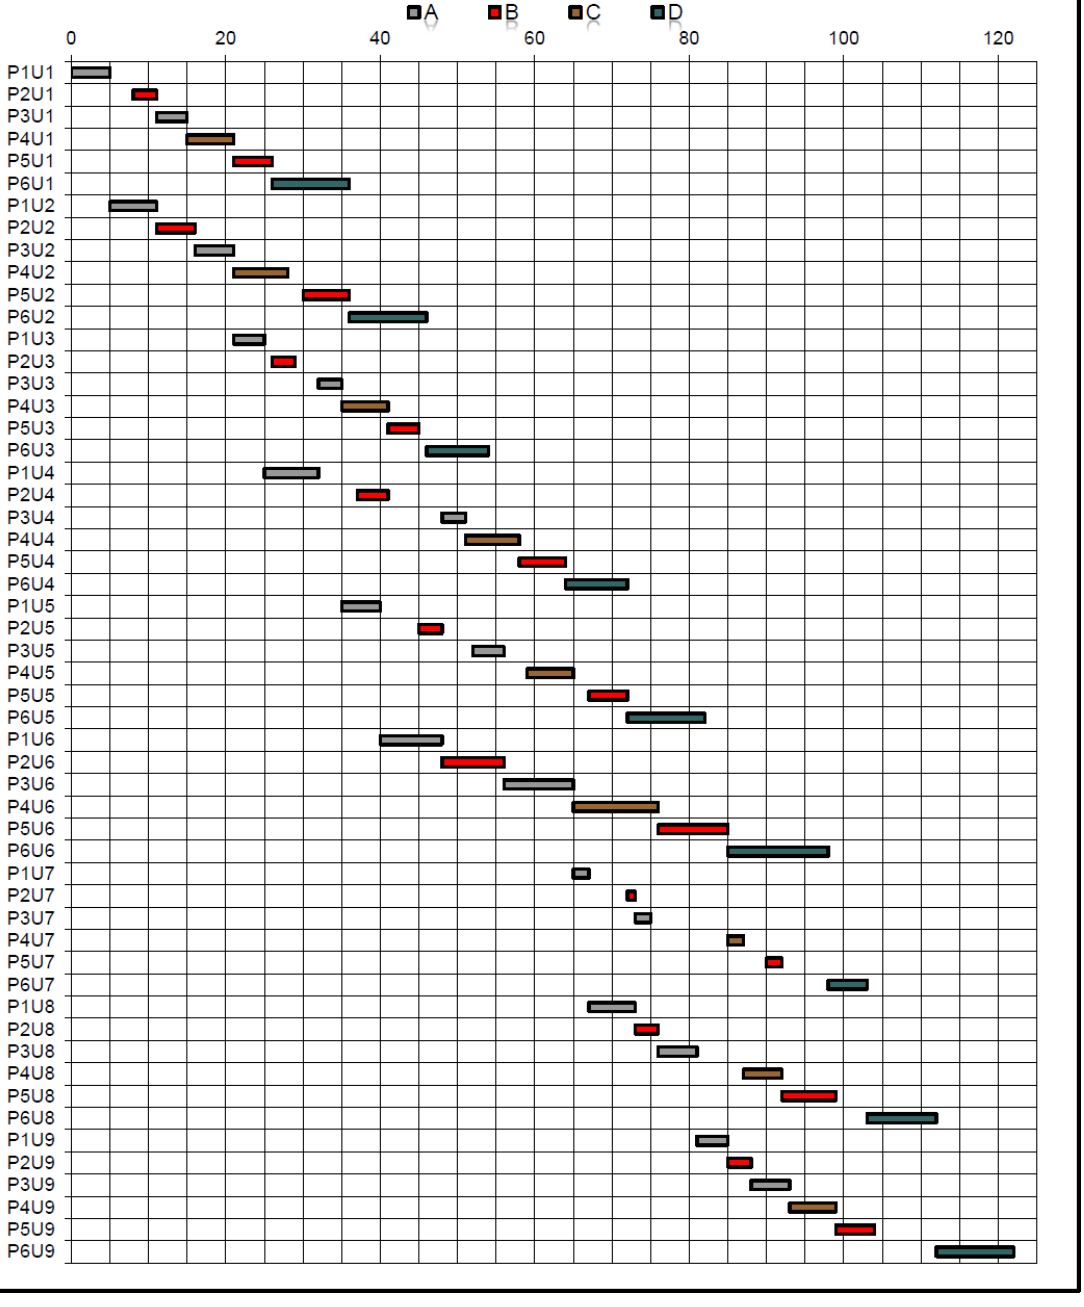
Figure 1: Schedule of the project in the three-criteria optimization problem (CS) with weighting criteria amounting to w 1 = w 2 = w 3 = 0.333